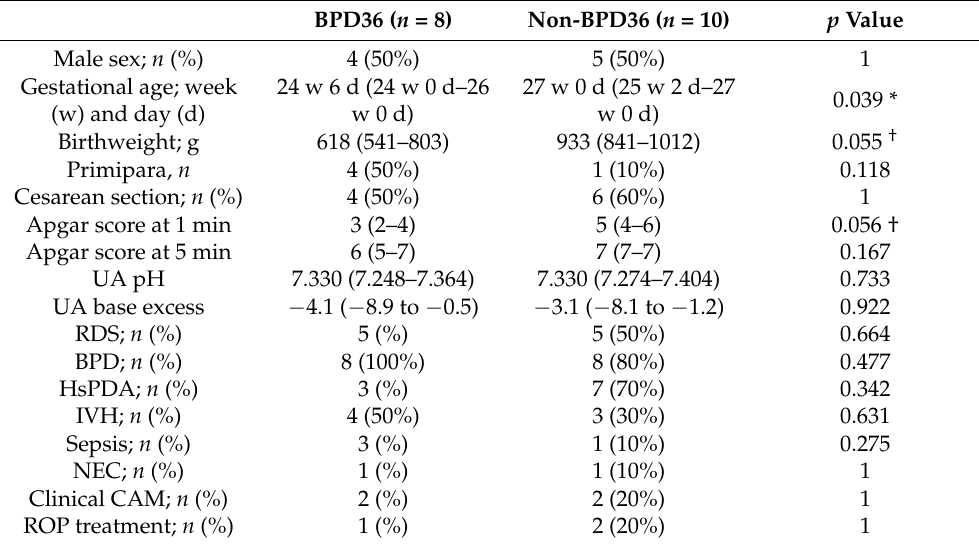
Table 2. Comparisons of Characteristics of BPD36 and non-BPD36